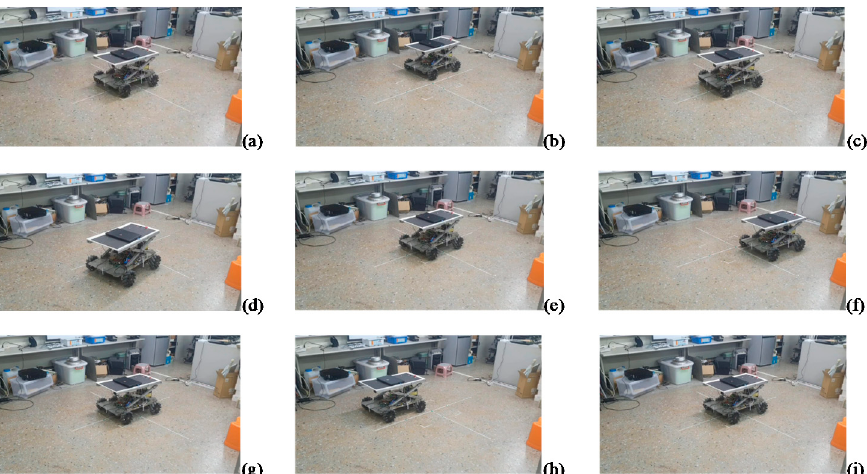
Figure 19. The captured pictures of the OMWAGV moving diagonally with RLS estimation com- pensation. ( a ) Starting position, ( b ) forward at an angle of 45 degrees to the left, ( c ) return to the starting position, ( d ) backward at an angle of 45 degrees to the right, ( e ) back to the starting position, ( f ) forward at an angle of 45 degrees to the right, ( g ) return to the starting position, ( h ) backward at an angle of 45 degrees to the left, ( i ) return to the starting position.